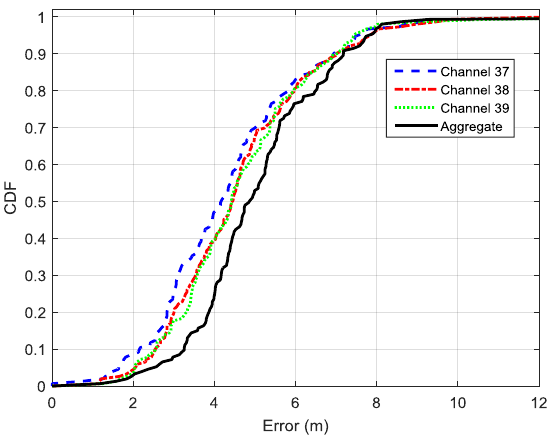
Figure 9. CDFs of location estimation errors by using separate FP databases and aggregate FP database.